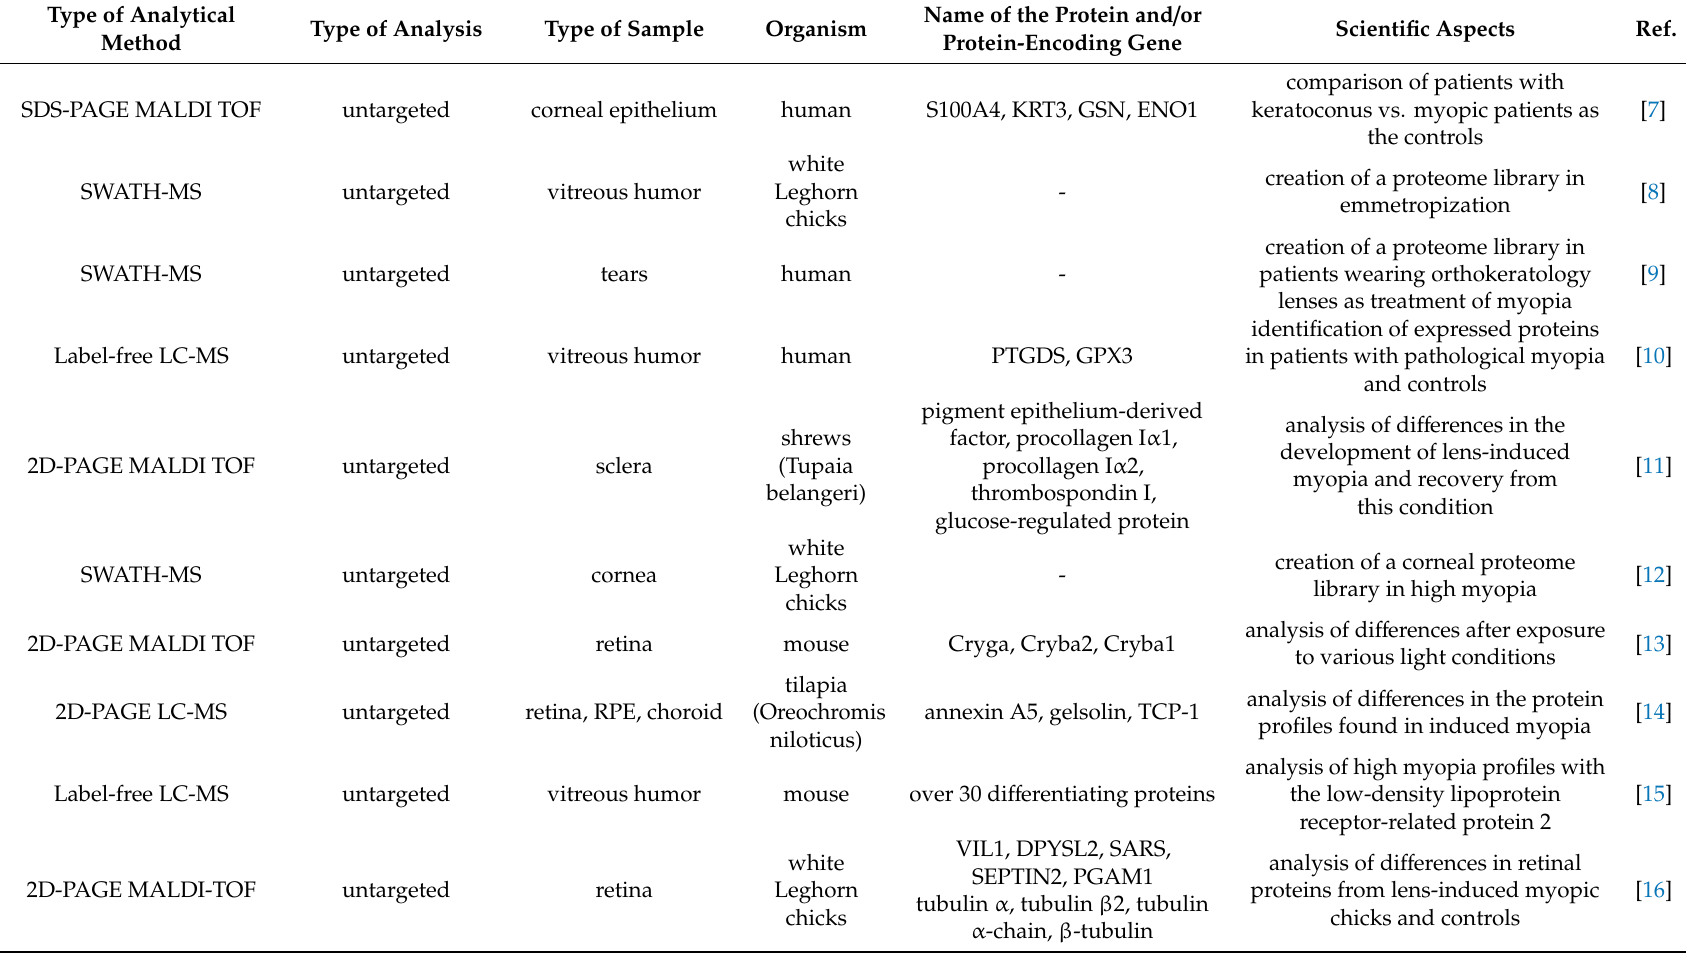
Table 1. Summary of published studies using proteomic analysis in myopia patients / animal